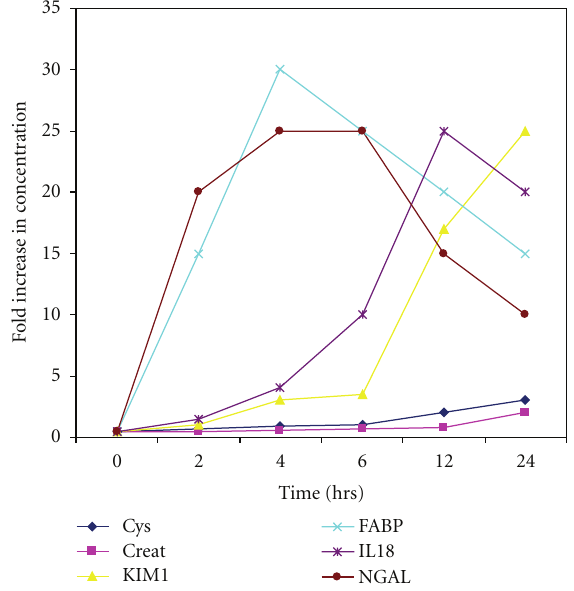
Figure 3: Urinary biomarker profiles in subjects who develop AKI after cardiopulmonary bypass (CPB) surgery. Abbreviations: AKI: acute kidney injury, defined as a 50% increase in serum creatinine from baseline; NGAL: neutrophil gelatinase associated lipocalin; IL- 18: interleukin 18; KIM-1: kidney injury molecule 1; L-FABP: liver- type fatty acid binding protein; Cys: cystatin c; creat: creatinine. Adapted and modified with permission from Devarajan